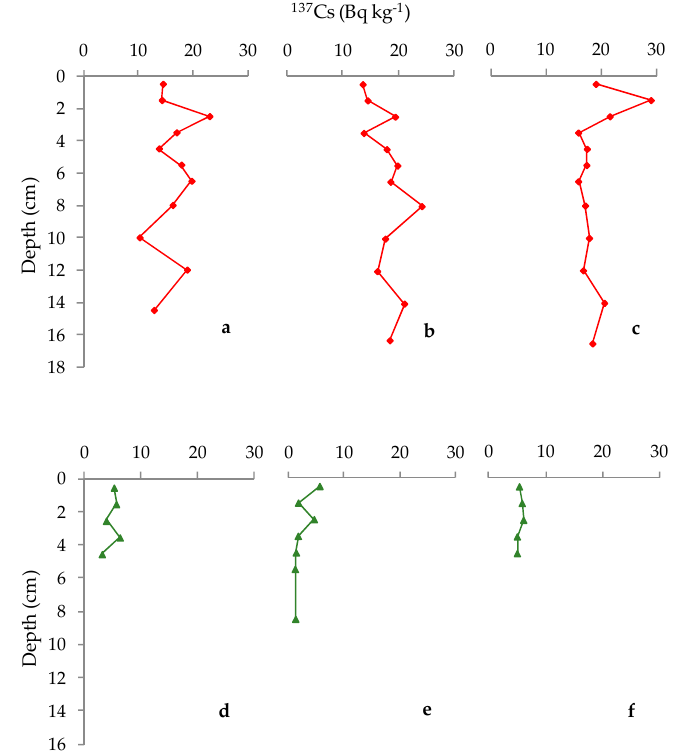
Figure 3. Depth profiles of 137 Cs for: ( a ) S1 ‐ EL14; ( b ) S1 ‐ ANOC16; ( c ) S1 ‐ INT17; ( d ) E1 ‐ EL14; ( e ) E1 ‐ ANOC16; and ( f ) E1 ‐ INT17.